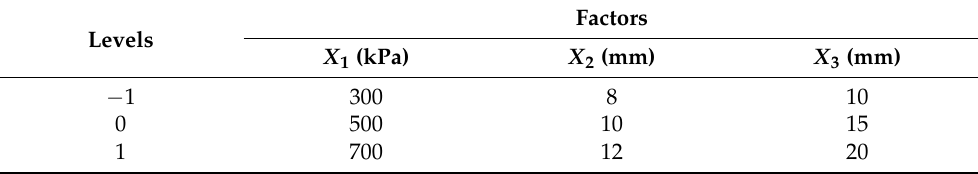
Table 2. Factor level